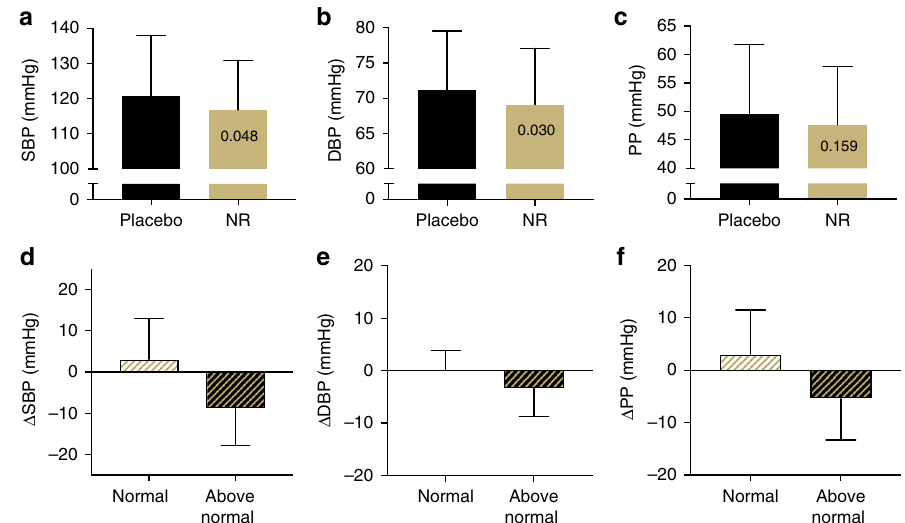
Fig. 3 Blood pressure. Effect of 6 weeks of oral placebo vs. NR supplementation on a systolic (SBP) and b diastolic (DBP) blood pressure, and c pulse pressure (PP) in healthy middle-aged and older adults as a whole N = 24 (Group A = 12; Group B = 12), and overall change from placebo in blood pressure parameters ( d − f ) in subjects with normal ( N = 11) vs. above normal ( N = 13) baseline BP. Data are mean ± SD. P- values reported in individual bars based on a one-tailed paired t -test (panels a − c only) and an adjusted alpha level set at 0.006